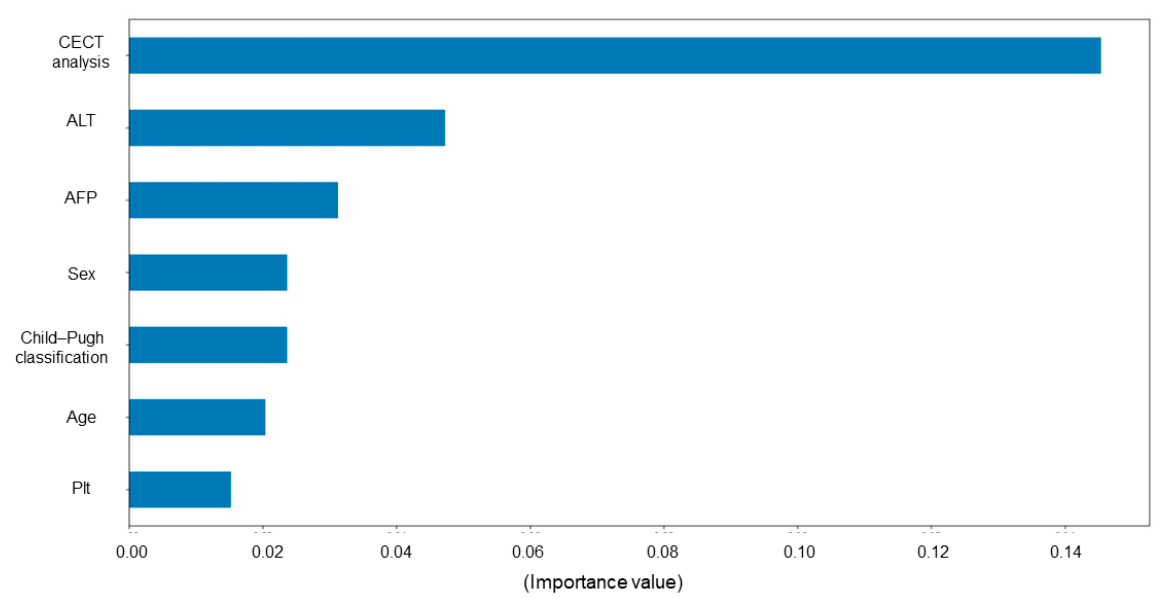
Figure 6. Permutation importance in each explanatory variable of our present deep learning model. A large positive value indicates the feature is very relevant to detect positive output. The color bar shows the feature value impact on early recurrence. CECT, contrast-enhanced computed tomography; ALT, alanine aminotransferase; AFP, alpha-fetoprotein; Plt, platelet counts.